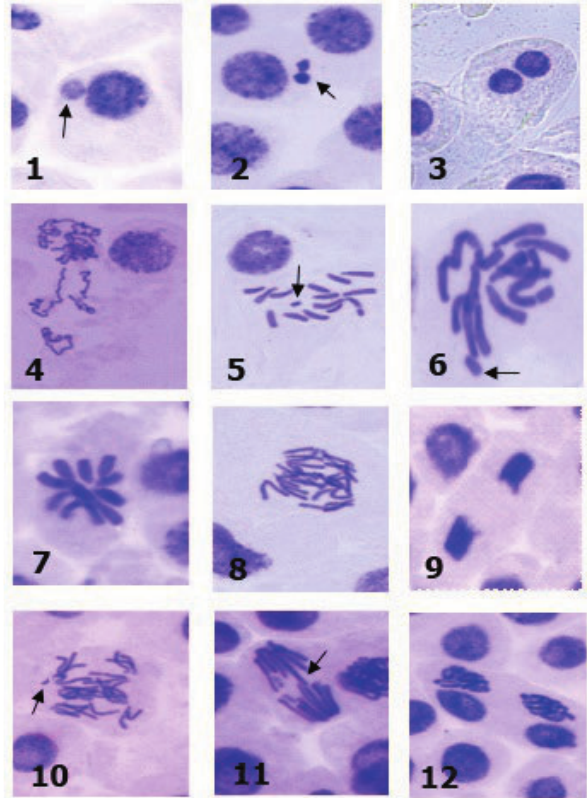
Figure 1. Chromosomal aberrations of Misr 3 cultivar root tips under the influence of AlCl 3 for different periods (6, 12, and 24 hr); (1, 2) micronuclei formation during interphase stage (arrows), (3) binucleated interphase, (4) irregular prophase, (5) C-metaphase with breaks (arrow), (6) disturbed metaphase, (7) star metaphase, (8) disturbed anaphase, (9) sticky anaphase, (10) breaks in anaphase (arrow), (11) bridge anaphase (arrow) and (12) star shape anaphase.